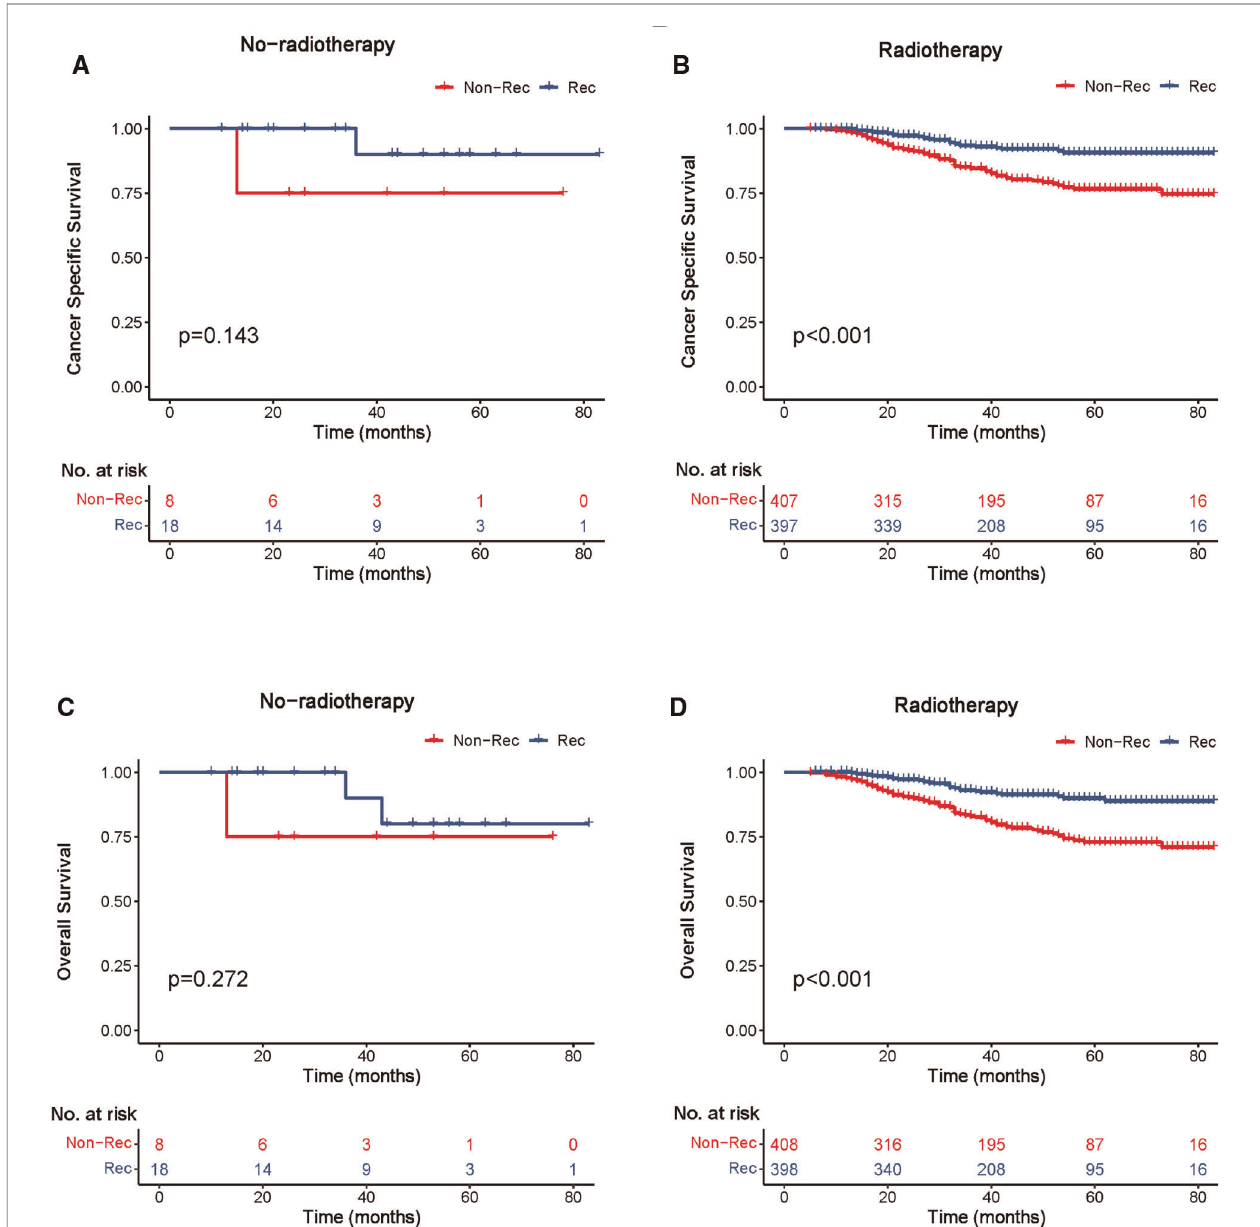
FIGURE 5 | Kaplan – Meier curves of breast cancer-speci fi c survival and overall survival in the reconstruction and non-reconstruction groups with or without radiotherapy. Breast cancer-speci fi c survival ( A ) no radiotherapy and ( B ) radiotherapy; overall survival ( C ) no radiotherapy and ( D )